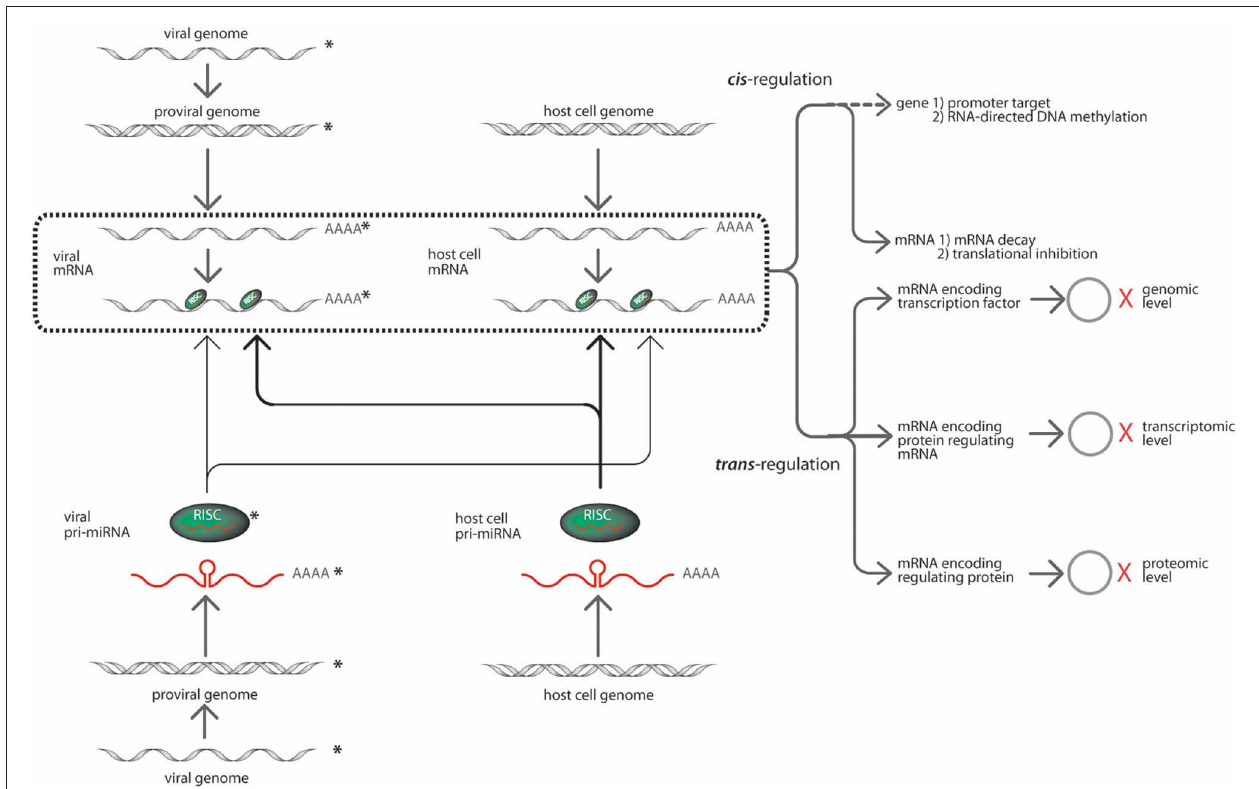
FIGURE 1 | The prospective targeting interactions of HIV-1 and cellular microRNAs (modified from Cullen, 2006). The interactions among HIV-1 and cellular microRNAs with their corresponding targets may occur in several modules. For instance, HIV-1 encoded microRNAs processed via the host RNAi machinery and incorporated into RISC (in green with the mature microRNA in red) are sourced from HIV-1 pro-viral strands (grey double helix) initially from precursor microRNAs (red lines with poly adenines). These HIV-1 microRNAs can target its viral transcripts or the cellular transcripts. The targeting interactions of microRNAs are shown in solid light arrow lines. In corollary, cellular microRNAs derived from precursor microRNAs (red lines with poly adenines) generated by the host cell genome (grey double helix). The host cellular microRNAs are encoded in the same manner and can target both viral and cellular transcripts where the targeting interactions are shown in solid bold arrow lines. The targeting of mRNA transcripts happens in a highly specific Watson and Crick base-pairing with either complete